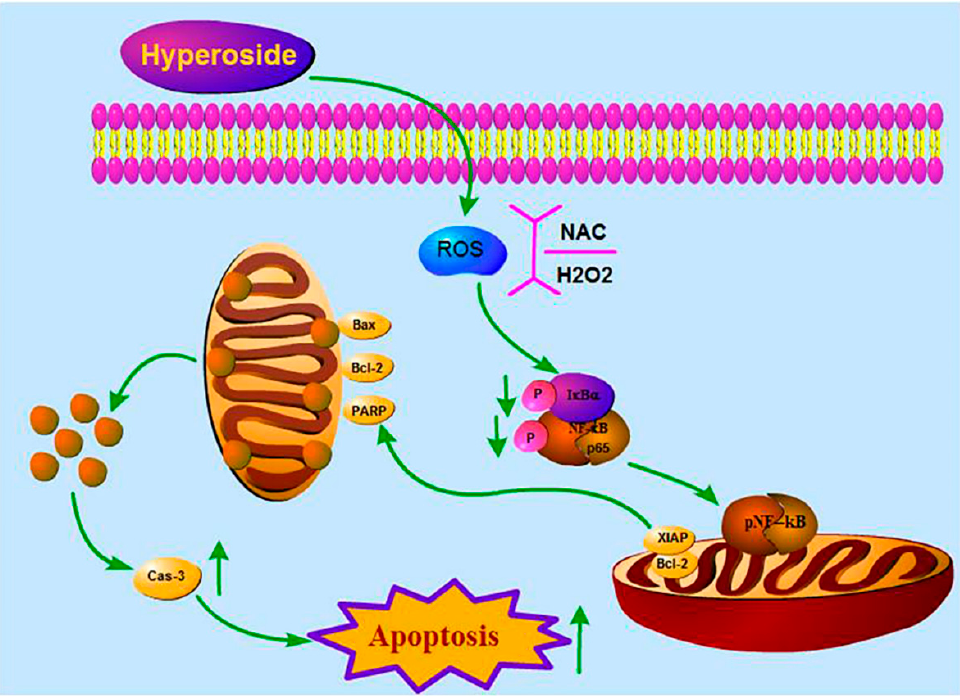
Figure 6. Inhibition of hypericin on ROS-mediated NF- κ B signaling and target gene expression in 4T1 cells. Hyperoside inhibited the activation of the NF- κ B pathway and reduced translocation of p-p65 in the nucleus by reducing ROS production in 4T1 cells. Inhibition of NF- κ B down-regulates the transcription of anti-apoptotic genes, such as Bcl-2 and XIAP, but it also induced the accumulation of Bax, which leads to mitochondrial dysfunction and leads to apoptosis by activating caspase-3.